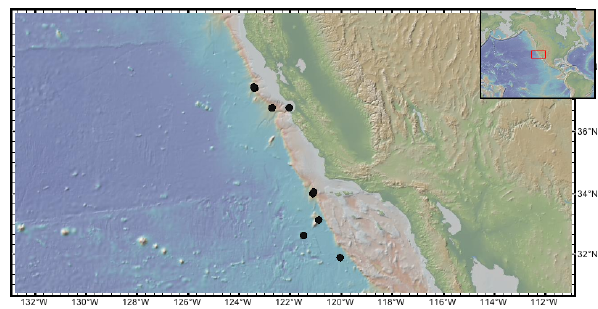
Figure 1. Left: photograph of bamboo coral specimen showing cal- cite internodes connected by gorgonin nodes. Right: cross-section view of gorgonin section (top) and calcite section (bottom), ex- hibiting evidence of growth in concentric rings. Photographs by M. Graziose.